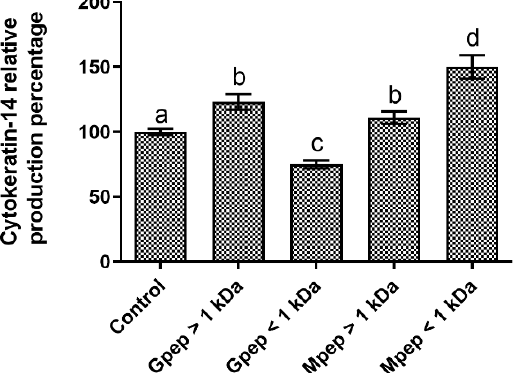
Figure 7. Cytokeratin-14 relative percentage of production in the presence of different peptide fractions relative to the basal level (control) in HaCat cells. Different letters represent the statistically significant differences ( p < 0.05) found between the samples tested.